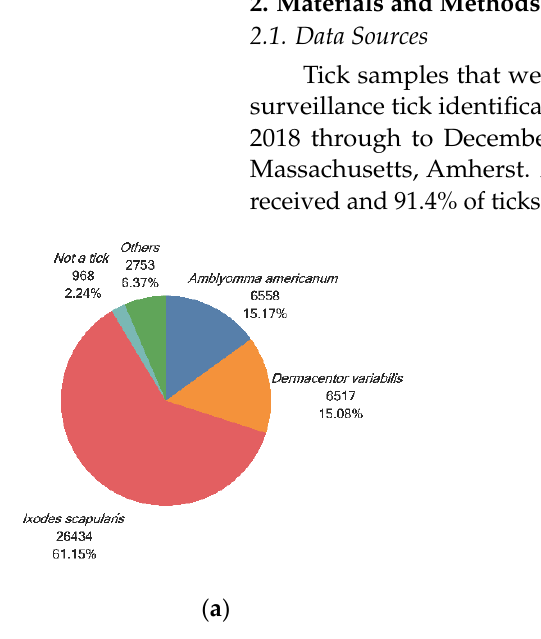
Figure 2. ( a ) Proportion of the tick species to the overall submission; ( b ) proportion of the tick species used in the training process.